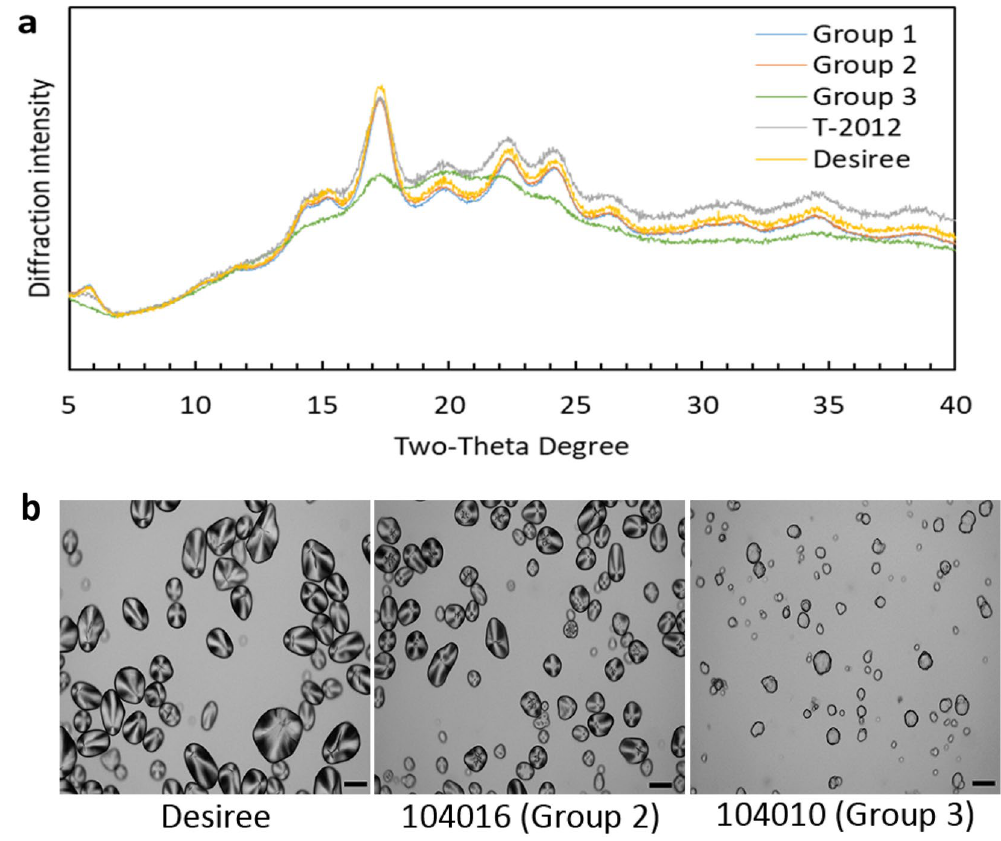
Figure 5. X-ray diffraction patterns and polarised light microscopy of potato lines from Groups 1, 2, and 3. ( a ) Average diffraction intensity for each group. The parental variety Desiree and the high-amylose line T-2012 were included for comparison. ( b ) Images of selected potato starches using polarised light microscopy. Scale bar = 40